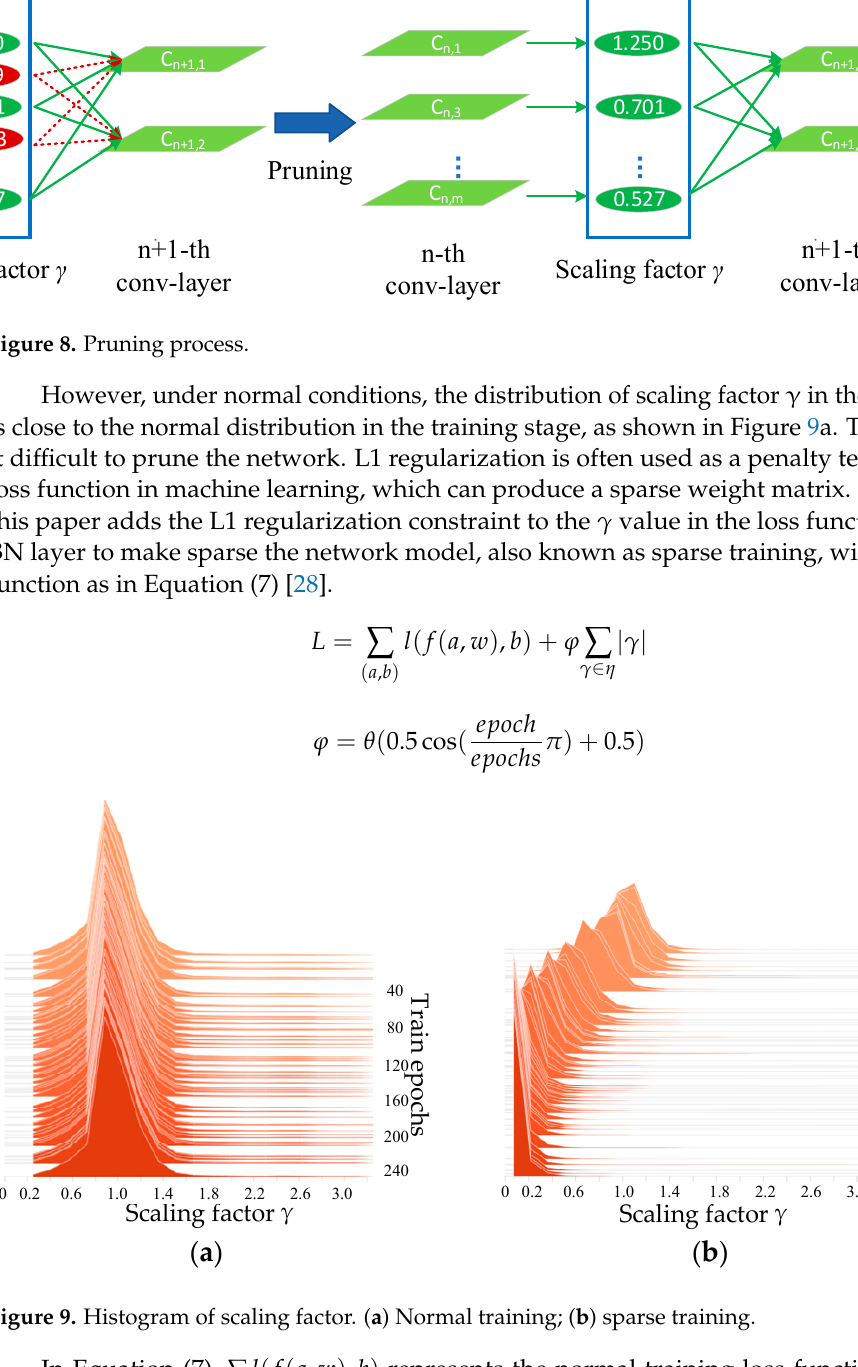
Scaling factor γ